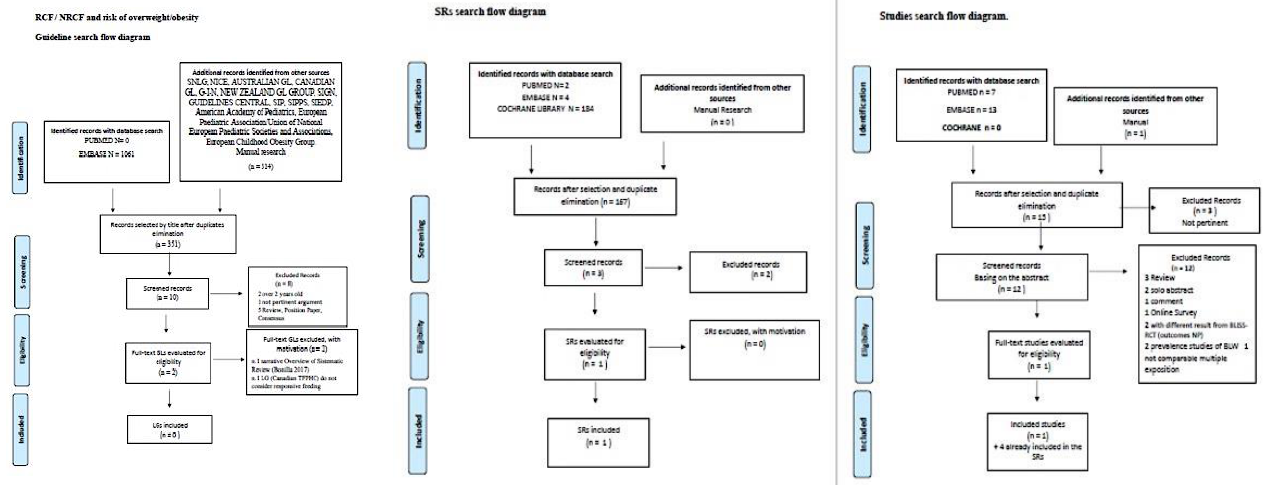
Figure 1. BLW/BLISS and risk of overweight/obesity. Flow diagram of the guidelines, SRs, and studies search.